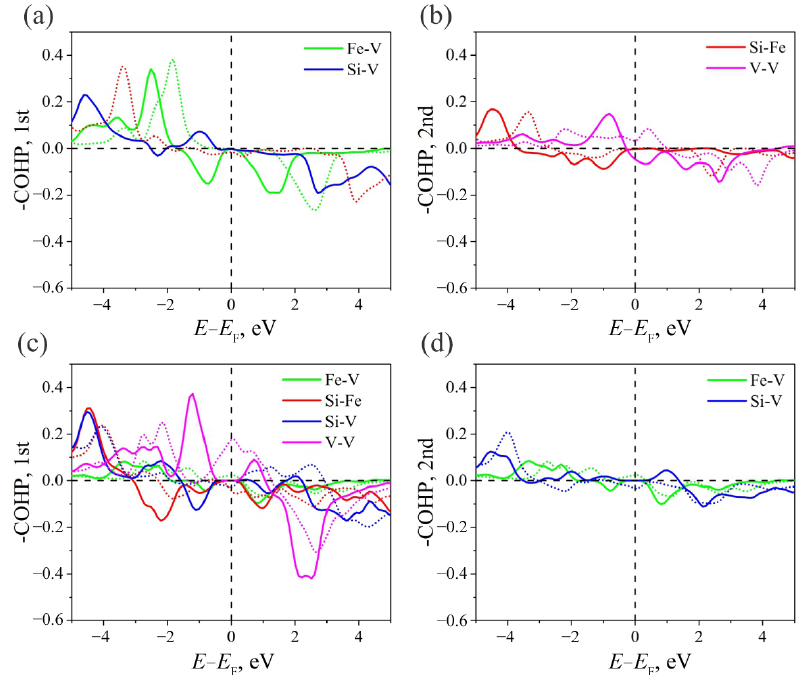
Figure 6. − COHP for ( a ) the first and ( b ) the second coordination spheres of atoms in the V 2 FeSi Heusler alloy of the L 2 1 structure. − COHP for ( c ) the first and ( d ) second coordination spheres of atoms in the V 2 FeSi Heusler alloy of the XA